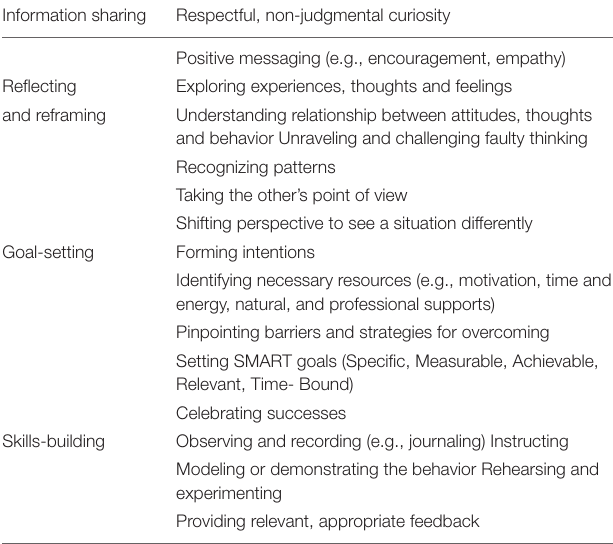
TABLE 1 | The ParentingWell Practice Profile action